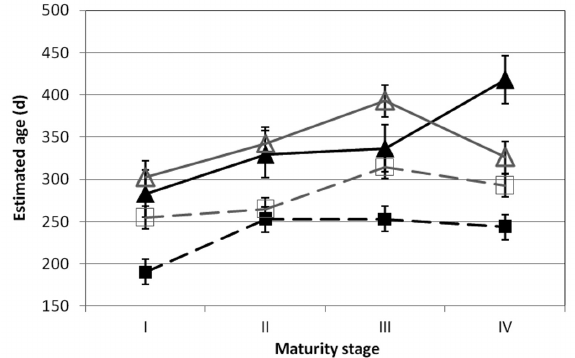
Fig. 5. – Mean age per maturation stage by sex and fishing ground. Full squares, west coast males (n=39; black dotted trend line); open squares, north coast males (n=23; grey dotted trend line); full tri- angles, west coast females (n=27; continuous black line); and open triangles, north coast females (n=33; continuous grey line). No post- spawning females were found.